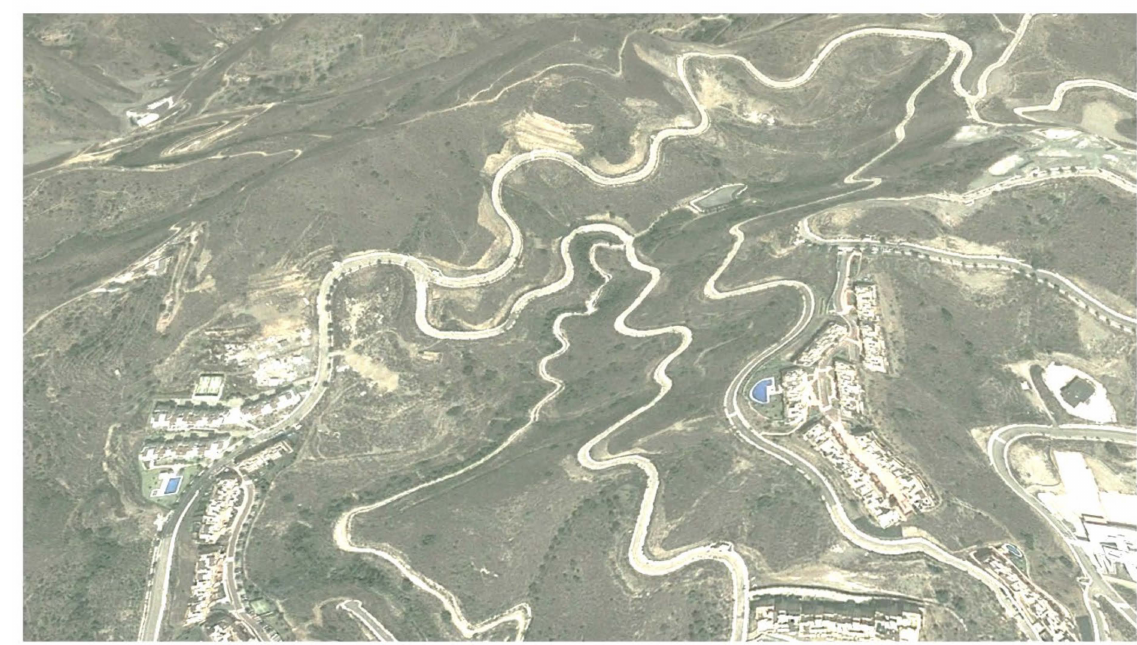
Figure 8. Detail of roads and clearings in the upper basins of the Piletas and Pollo Zamora streams (2007